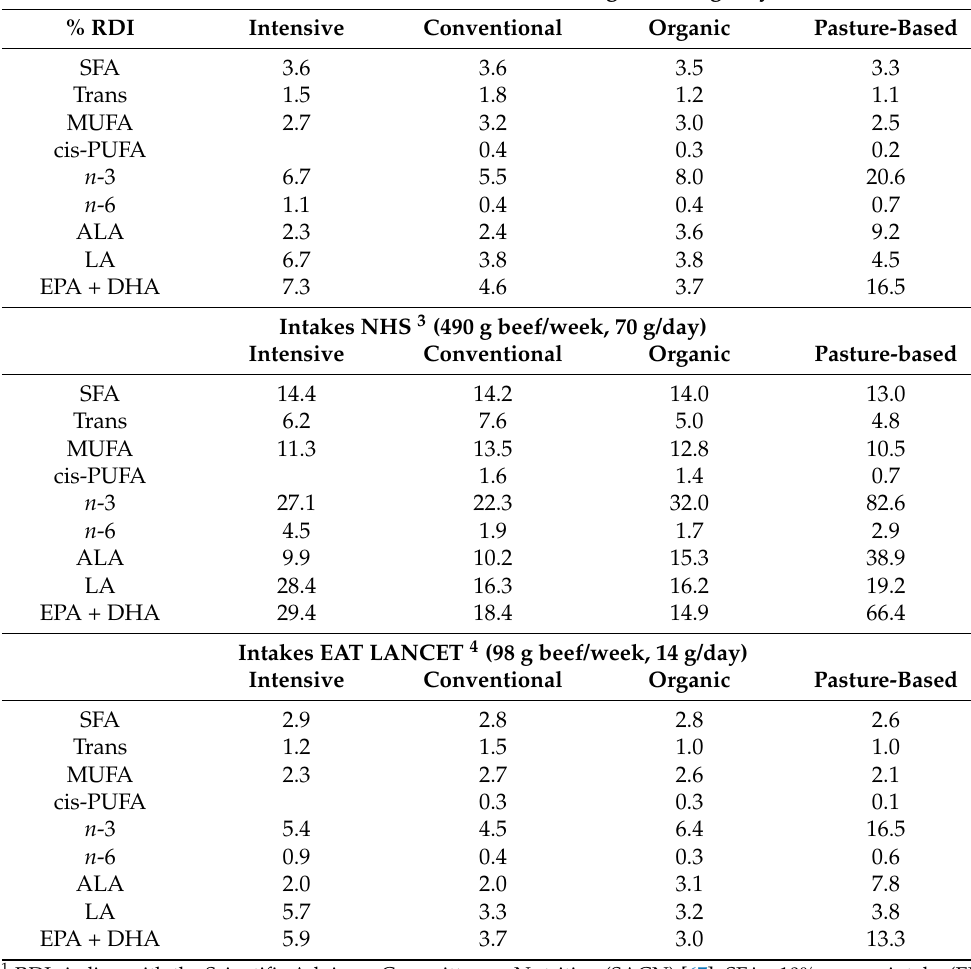
Table 2. Predicted fatty acid intakes from beef from four different feeding systems (Intensive: INT; Conventional: CON; Organic: ORG; Pasture-Based: PB) as a percentage of recommended daily intake (RDI) 1 , based on three different intake scenarios (NDNS, NHS, EAT LANCET) averaged across age and sex; assuming beef fat content of 10.61 g/100 g (averaged from 23 categories of cooked beef cuts) and beef fat to be 93.5% fatty acids, according to the McCance and Widdowson’s composition of foods integrated dataset [38].